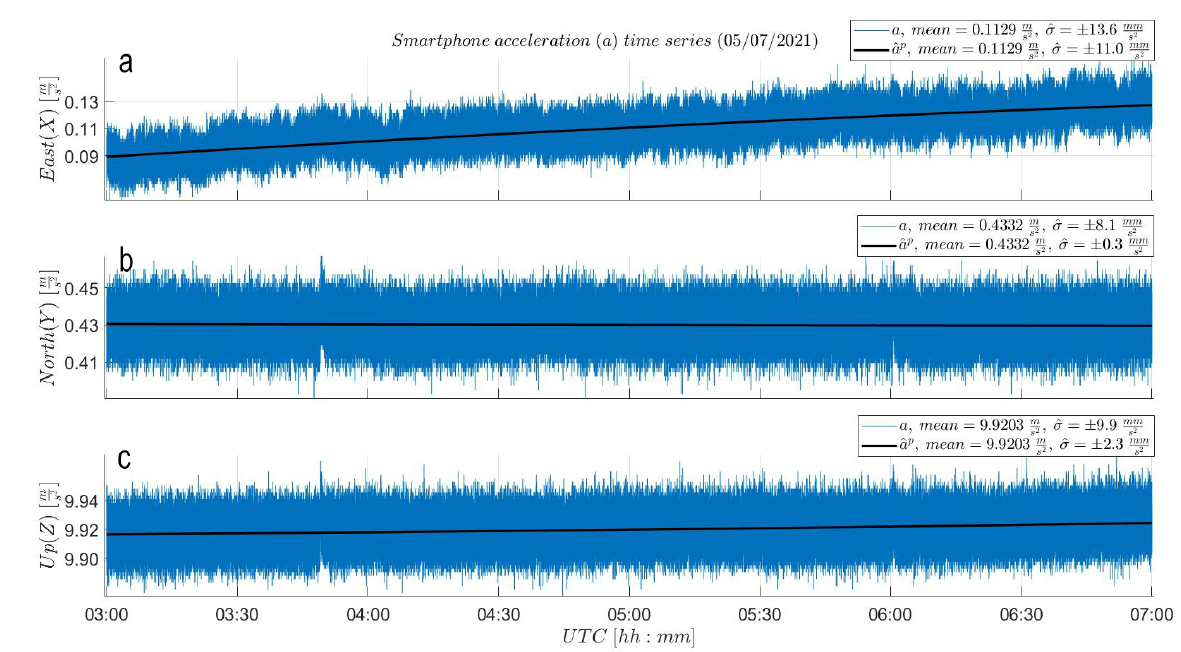
Figure A1. ( a ) East, ( b ) North and ( c ) Up smartphone accelerometer LS polynomial fitting: The process was run on the four-hour-long steady MI acceleration time series ( a ) in order to define the noise level (ˆ e ) from Figure 4. The East component in ( a ) is influenced by a linear drift error.